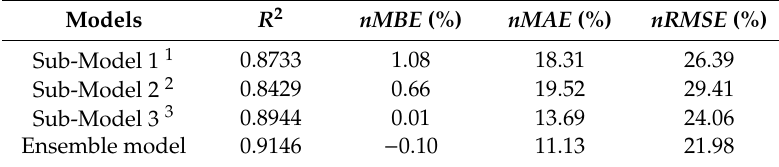
Table 4. The performance of the sub-models and the ensemble model using the testing set.